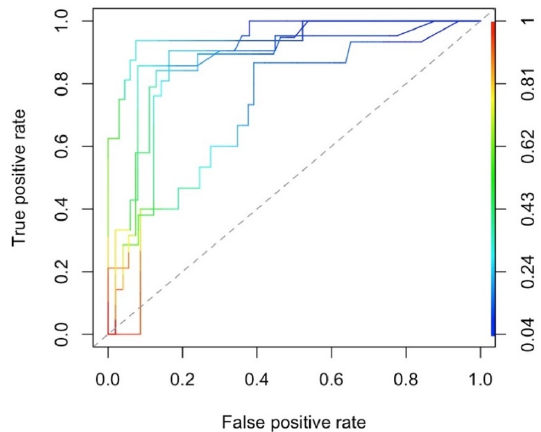
Figure A2. Receiver operating curve of all five folds from the five-fold cross validation of the neuropathy case-control prediction model.